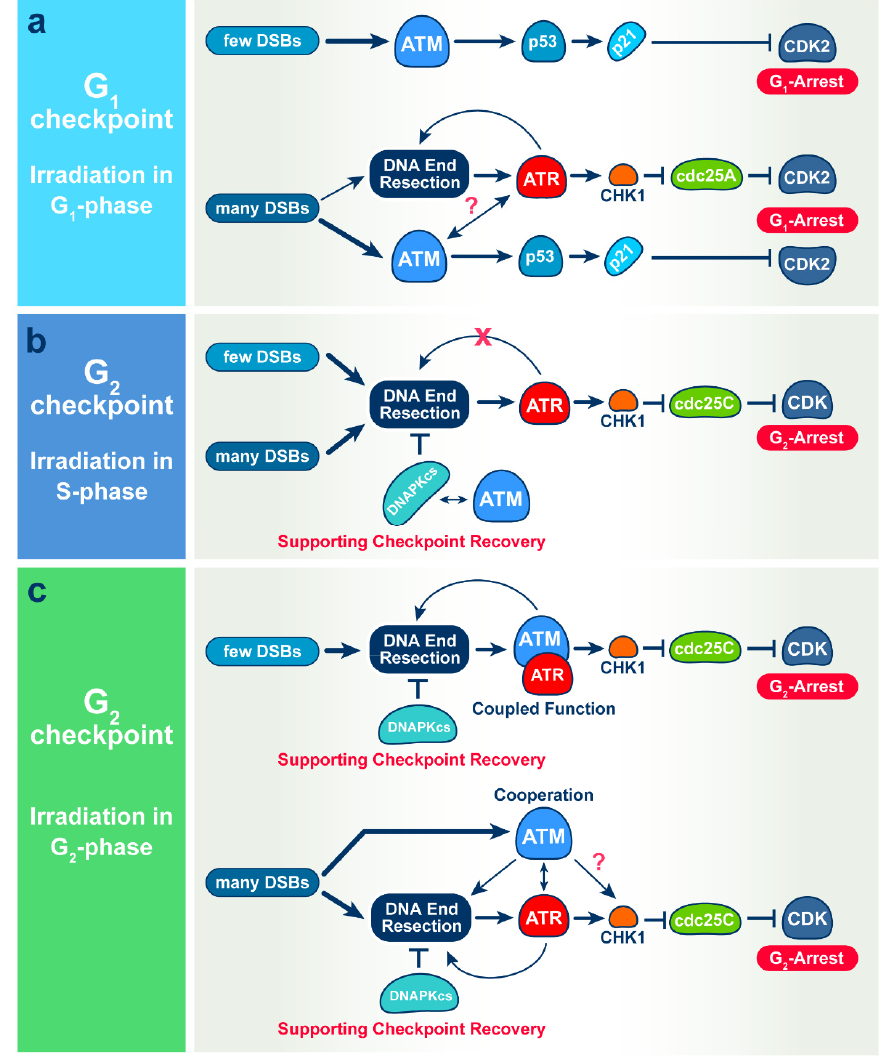
Figure 7. Mechanisms of IR-induced checkpoints in G 1 ( a ), S ( b ) and G 2 ( c ) phase of the cell cycles. See text for details.